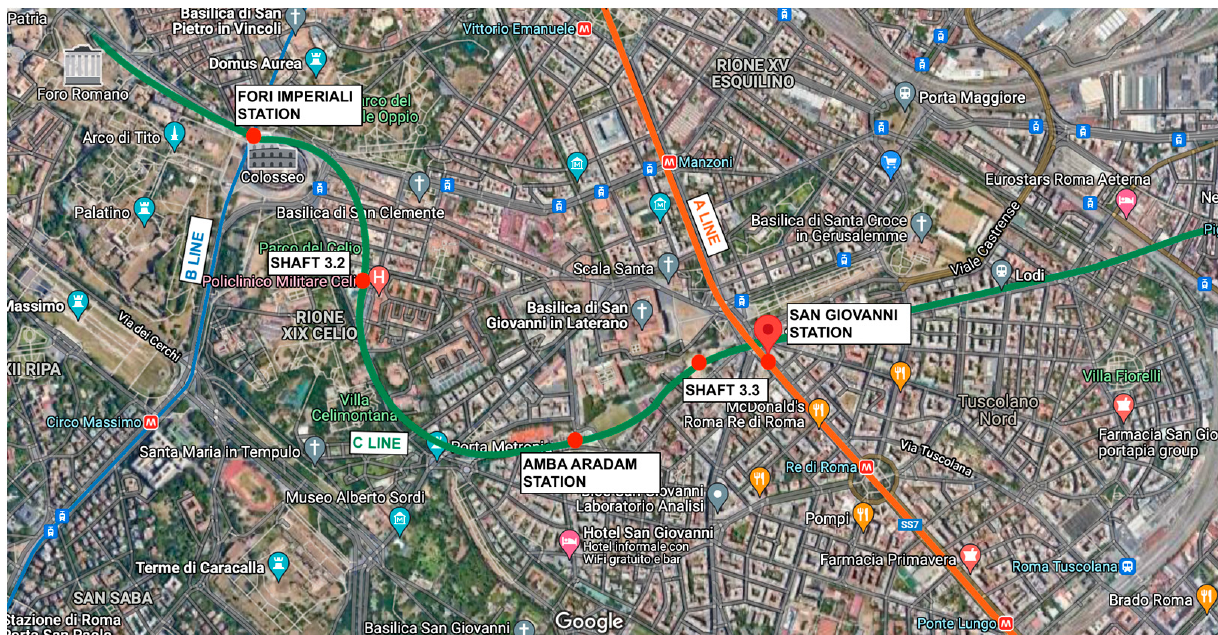
Figure 2. Map showing the T3 section of the Line C subway, the stations, the inter-tract shafts and the interaction with the other subway lines, Rome (Italy), edited from (https://goo.gl/maps/zPUUjveLSWBzj7nC9, accessed on 28 January 2022), [27] .